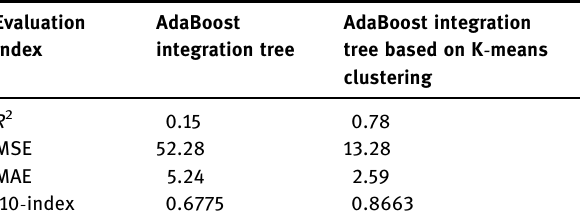
Table 6: Comparison of prediction accuracy between the three models